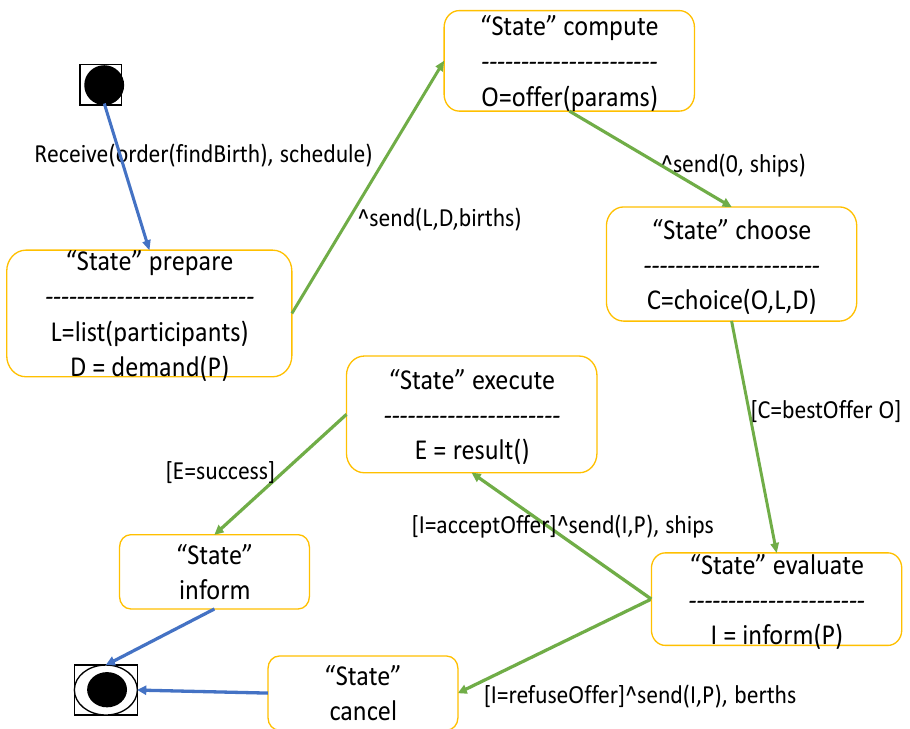
Figure 8. Model of the satisfaction plan for the goal “launching the CNP”.